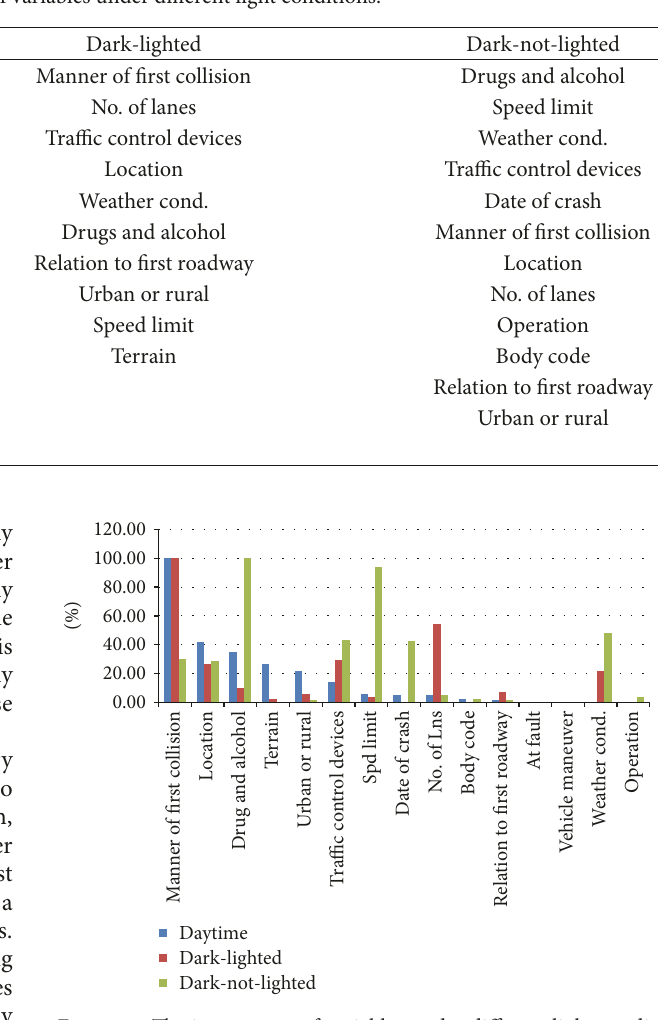
Figure 5: The importance of variables under different light condi-